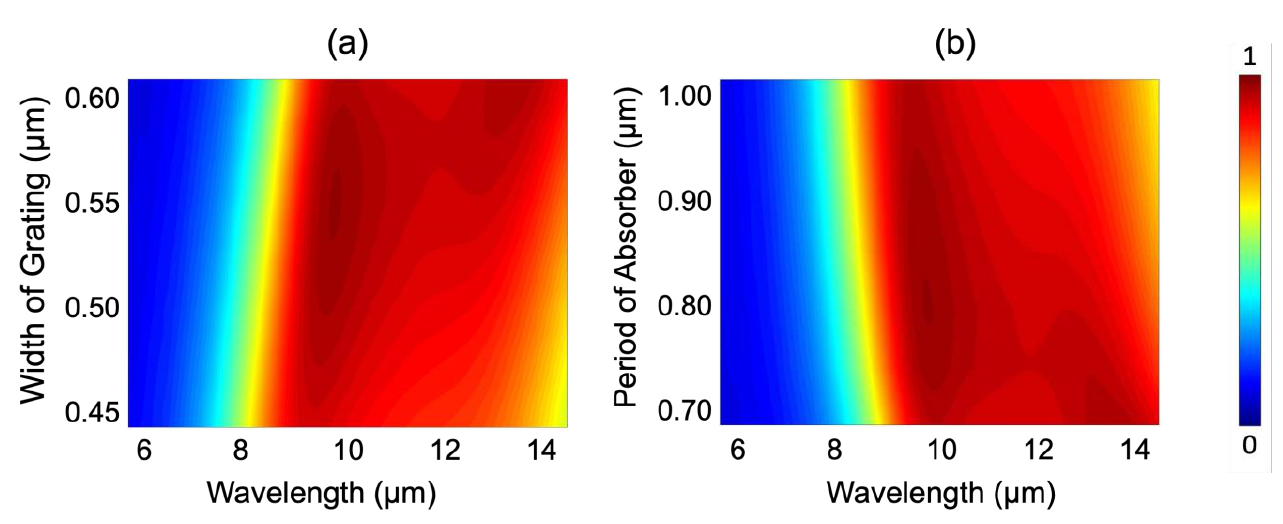
Figure 9. Simulated absorption behavior for absorber as a function of ( a ) width of the wire grating and ( b ) period of the microstructure: as the geometric parameters change, the position of the absorption spectrum is almost insensitive.